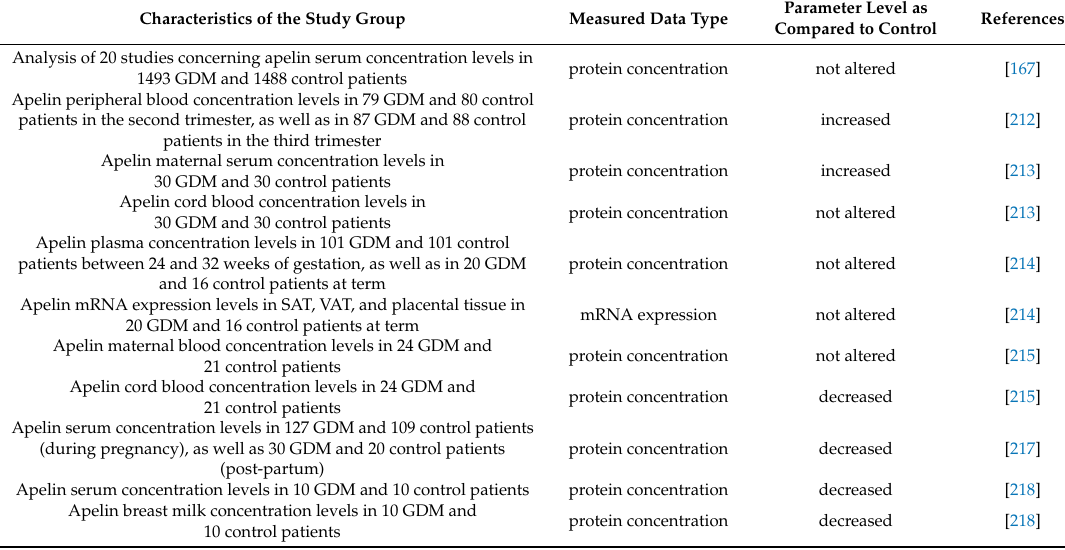
Table 1. The summary of data concerning apelin concentration and apelin mRNA expression levels in GDM patients as compared to control